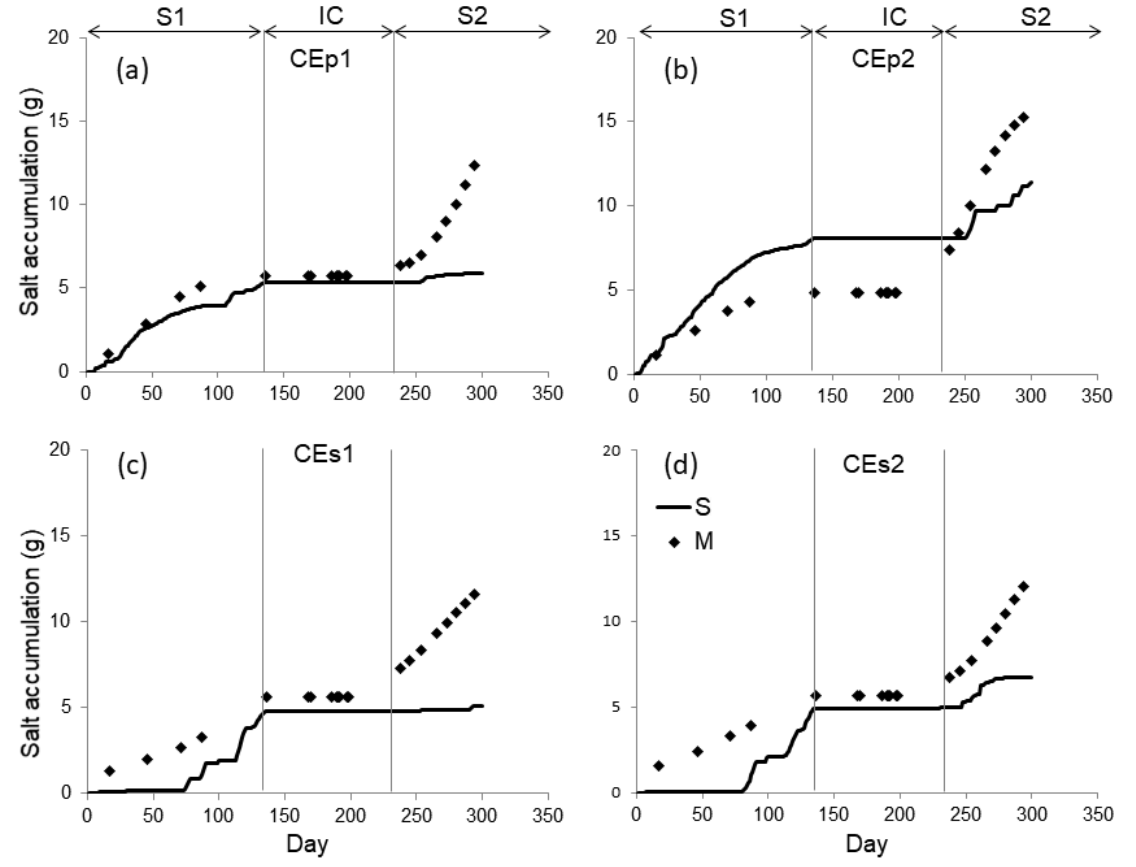
Figure 4. Dynamics of salt accumulation in plant biomass of E. stagnina measured in dry shoot and root biomass (M) and simulated with HYDRUS-1D (S) for the three treatments during the experiment. S1 is the first cropping season, IC is the intercropping season, S2 is the second cropping season, CT1 and CT2 are the columns with bare soil, CEp1 ( a ) and CEp2 ( b ) are the columns cultivated permanently with E. stagnina , CEs1 ( c ) and CEs2 ( d ) are the columns cultivated with seasonal E. stagnina.